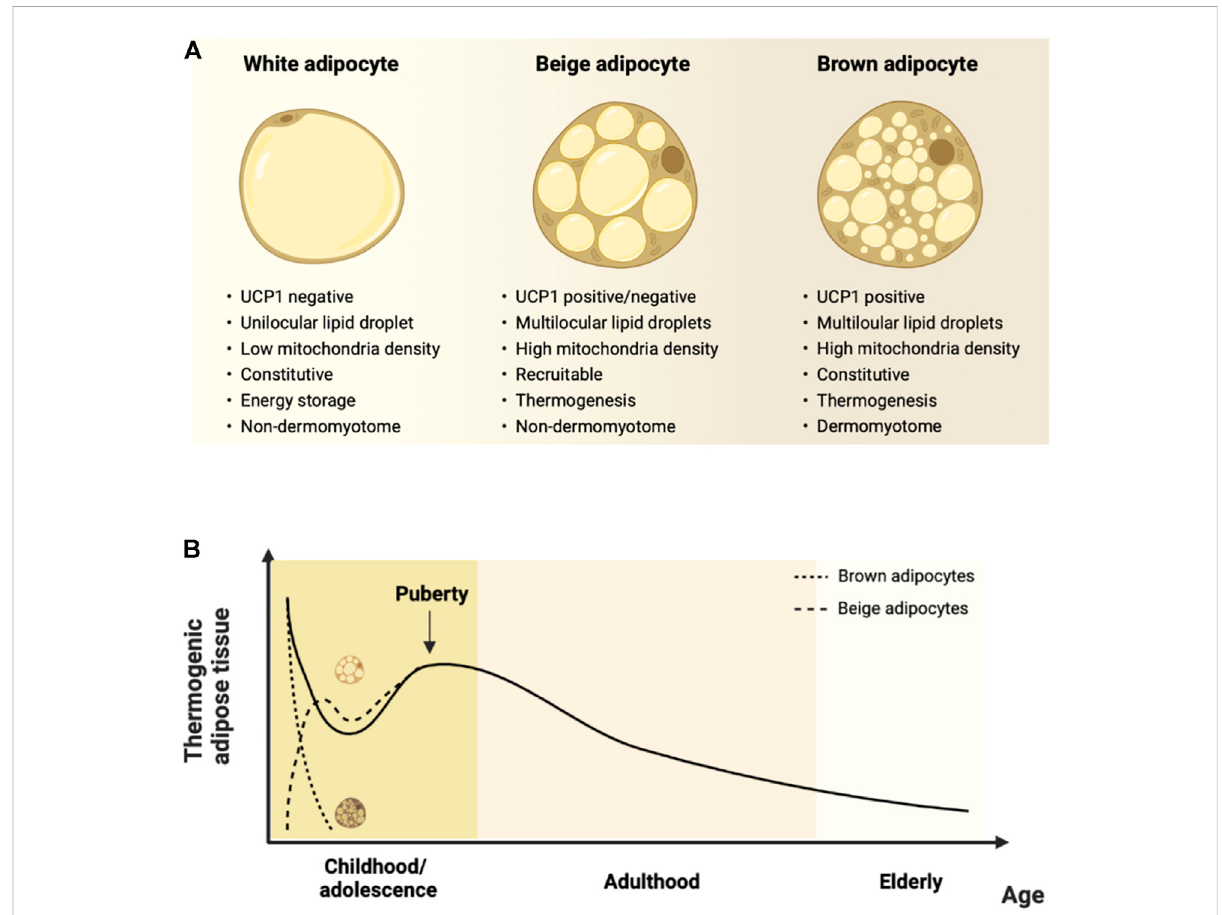
FIGURE 1 Characteristics of thermogenic adipocytes and their changes over the lifespan. (A) . Beige and brown adipocytes differ from white adipocytes concerning morphological and functional features. Brown adipocytes arise prenatally from a dermomyotome-derived precursor, are located within dedicatedadiposedepots,andareconstitutivethermogenicadipocytes.Beigeadipocyteshaveanon-dermomyotomeorigin,ariseprenatallywithin white adipose depots, and are recruited by thermogenic stimuli. (B) . Human thermogenic adipose tissue occurrence according to age. Thermogenic adipose depots are found at birth, decline throughout infancy, and increase transiently during puberty. There is a gradual decrease during adulthood until elderly ages. Molecular studies indicate that ‘ classical ’ dermomyotome-derived brown adipocytes developing prenatally are found at dedicateddepots and rapidly involute after birth. Conversely, non-dermomyotome-derived beige adipocytesarise postnatally within white adipose depots. Figure created with